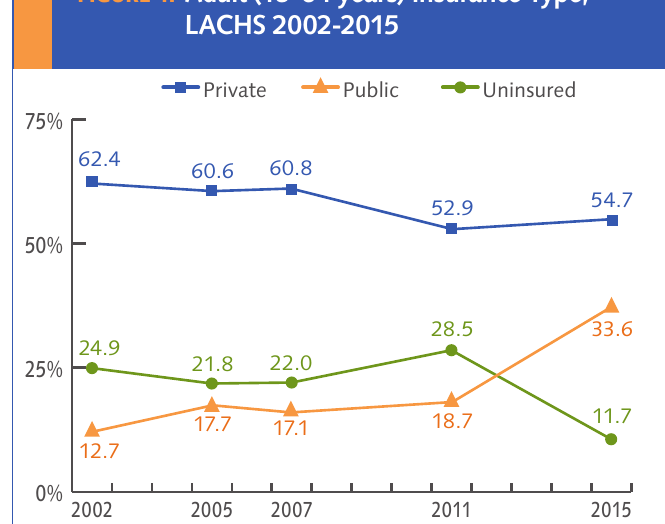
FIGURE 1: Adult (18-64 years) Insurance Type, LACHS